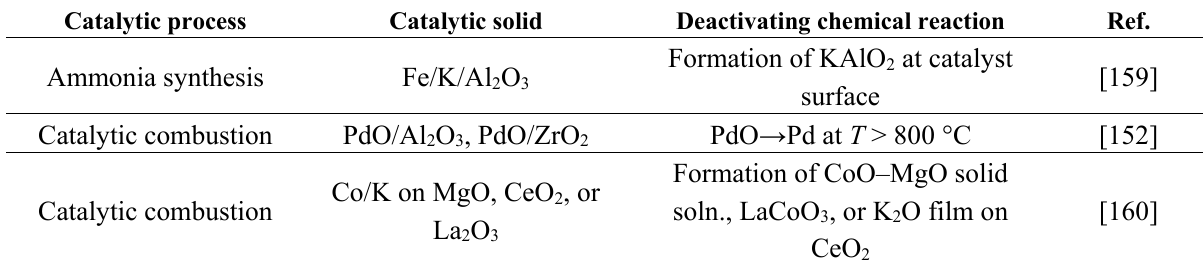
Table 14. Examples of Solid-State Transformations Leading to Catalyst